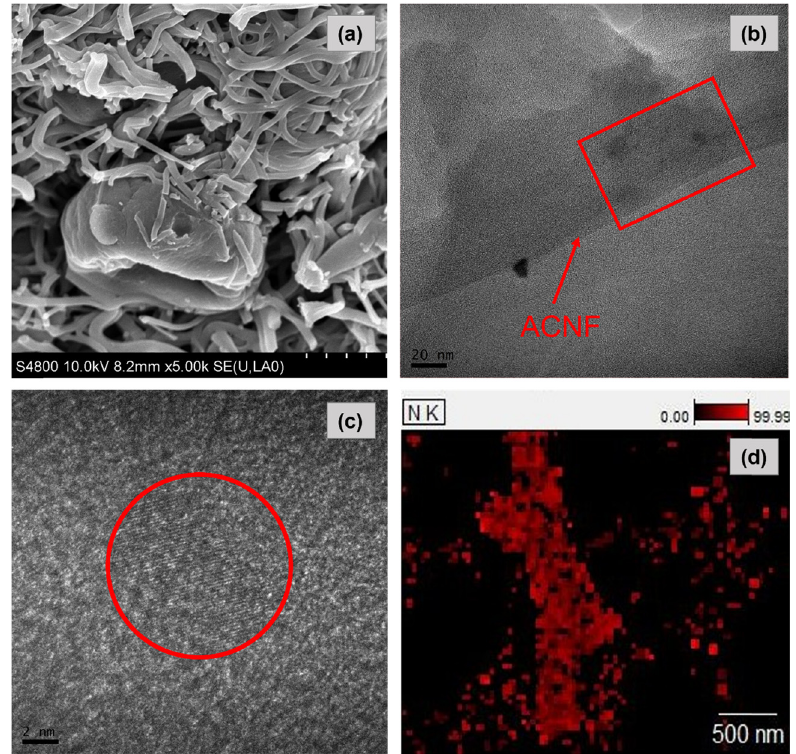
Figure 8: ( a ) SEM image at magni fi cation of 5,000 × ; ( b and c ) TEM images at di ff erent magni fi cations; and ( d ) EDX mapping of PEI - impregnated GRHC/ACNFs.